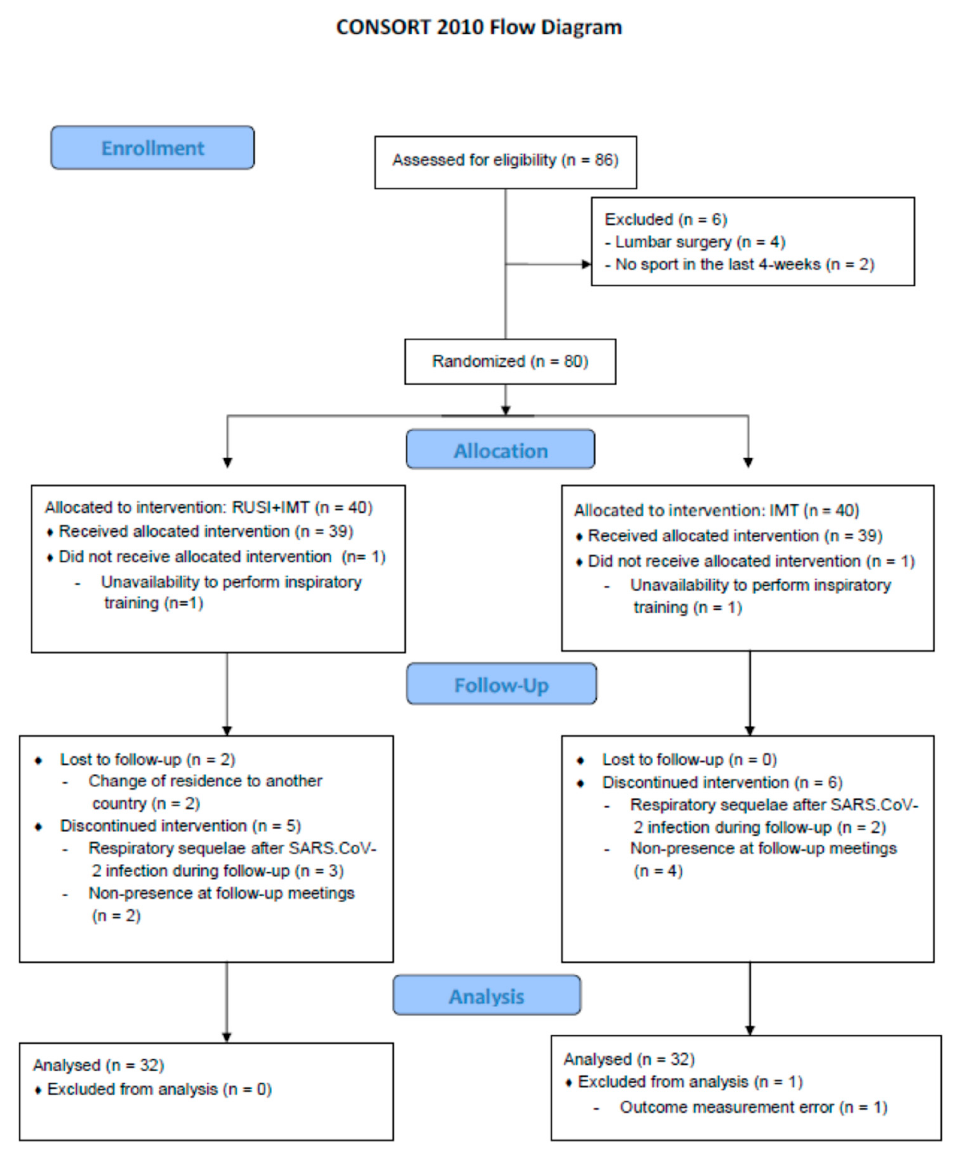
Figure 4. Flow diagram. Abbreviations: IMT, inspiratory muscle training; RUSI, Rehabilitative Ultrasound imaging. Table 1. Descriptive data for the total sample and their comparison for RUSI+IMT and IMT groups.